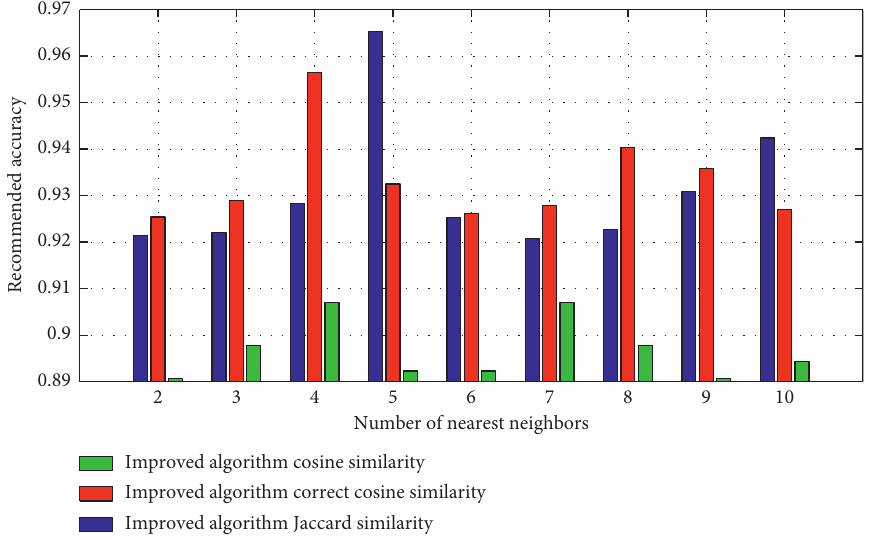
Figure 10: The accuracy of the algorithm in this paper’s recommendation to the first